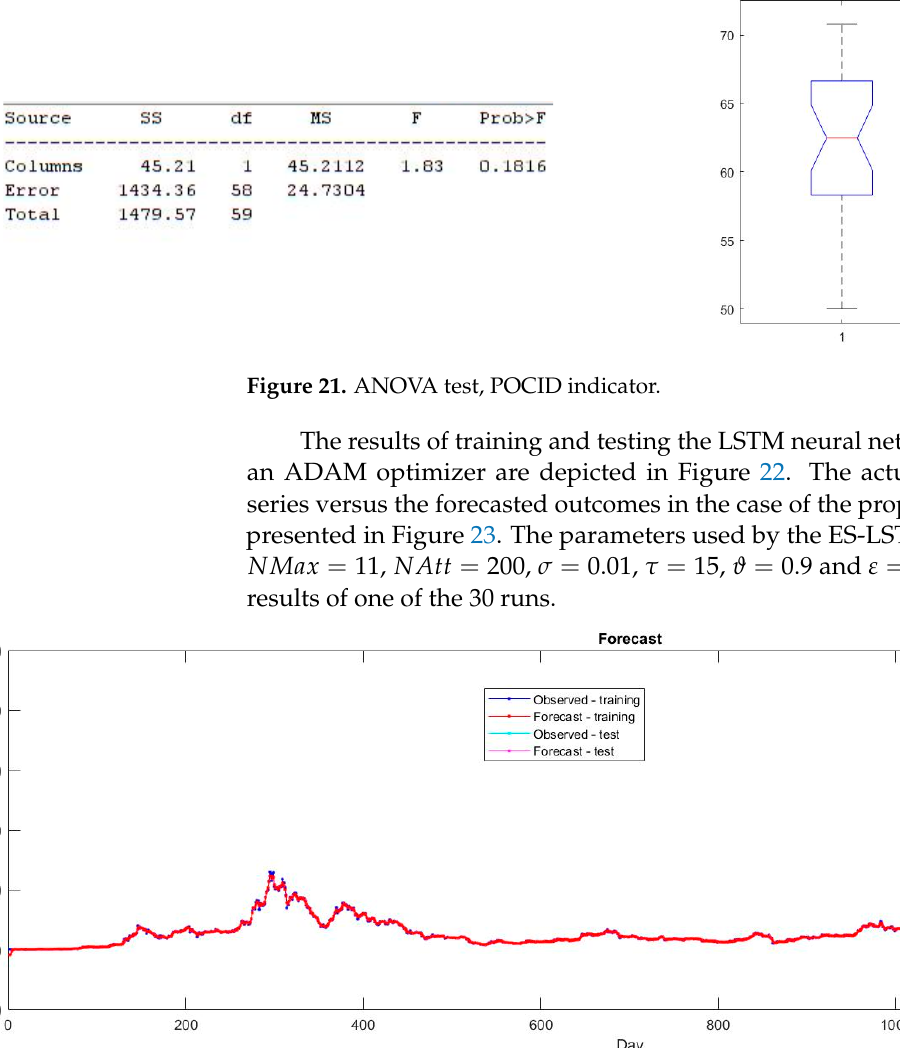
Figure 20. ANOVA test, F 1 indicator.